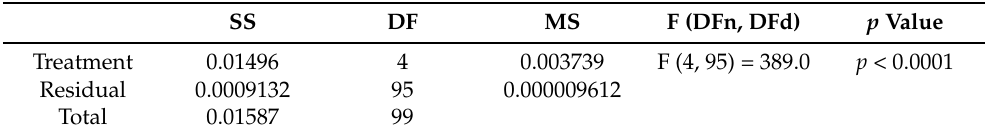
Table 11. ANOVA test of the achieved classification results using the optimized voting ensemble